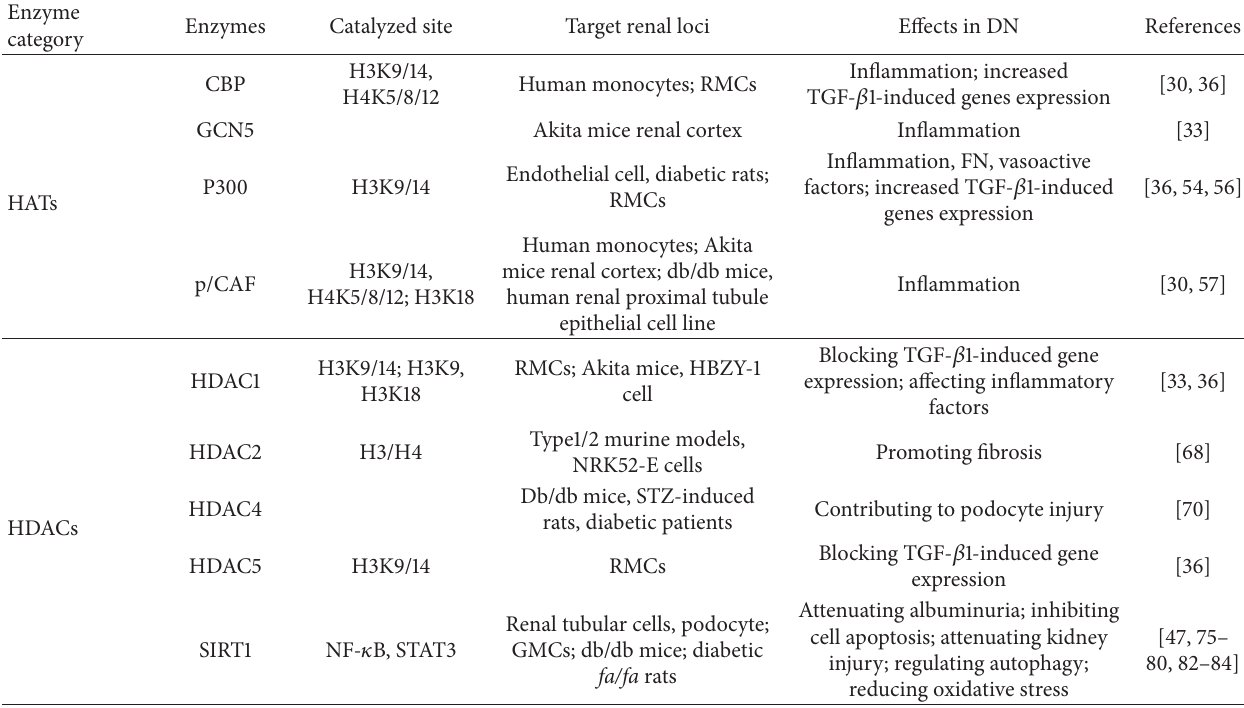
Table 2: Reported HATs/HDACs in